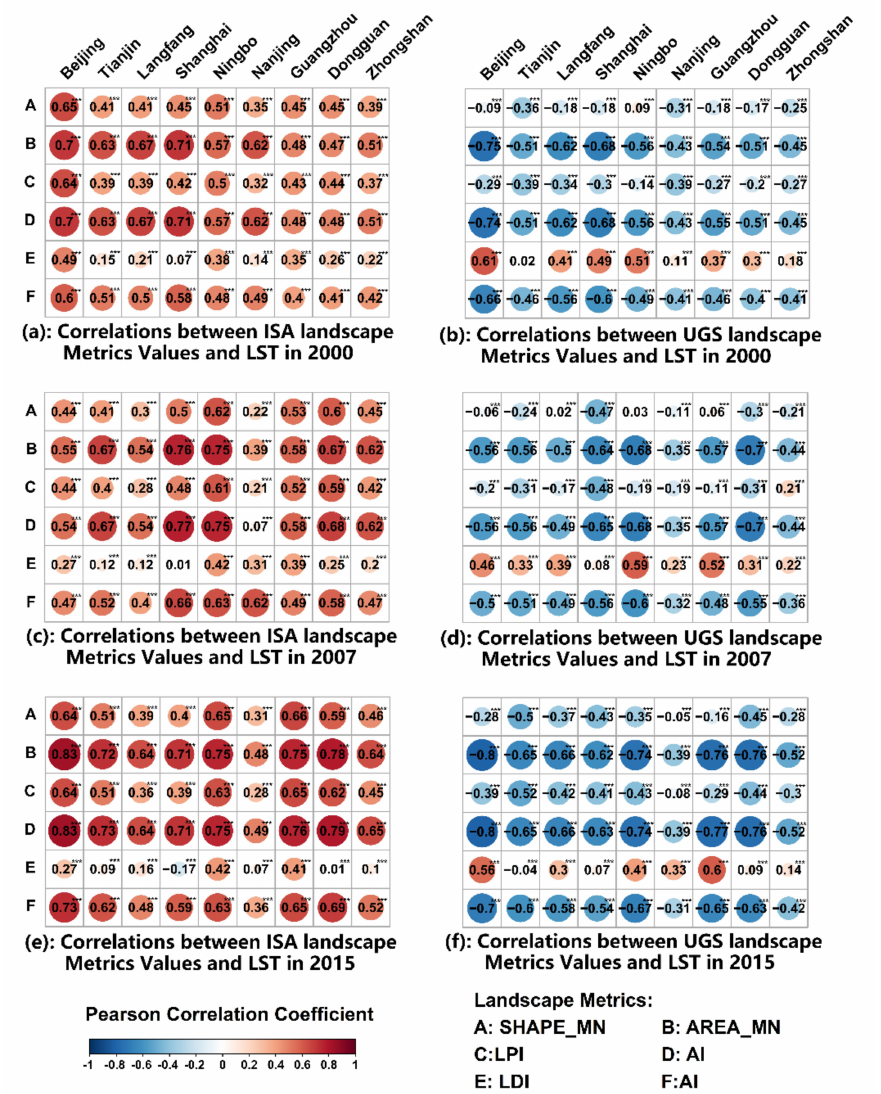
Figure 10. Pearson correlation coefficients between LST and ISA (and UGS) landscape configuration metrics within cities considered in this study, from 2000 to 2015. ( * denotes p < 0.05; ** denotes p < 0.01; and *** denotes p <